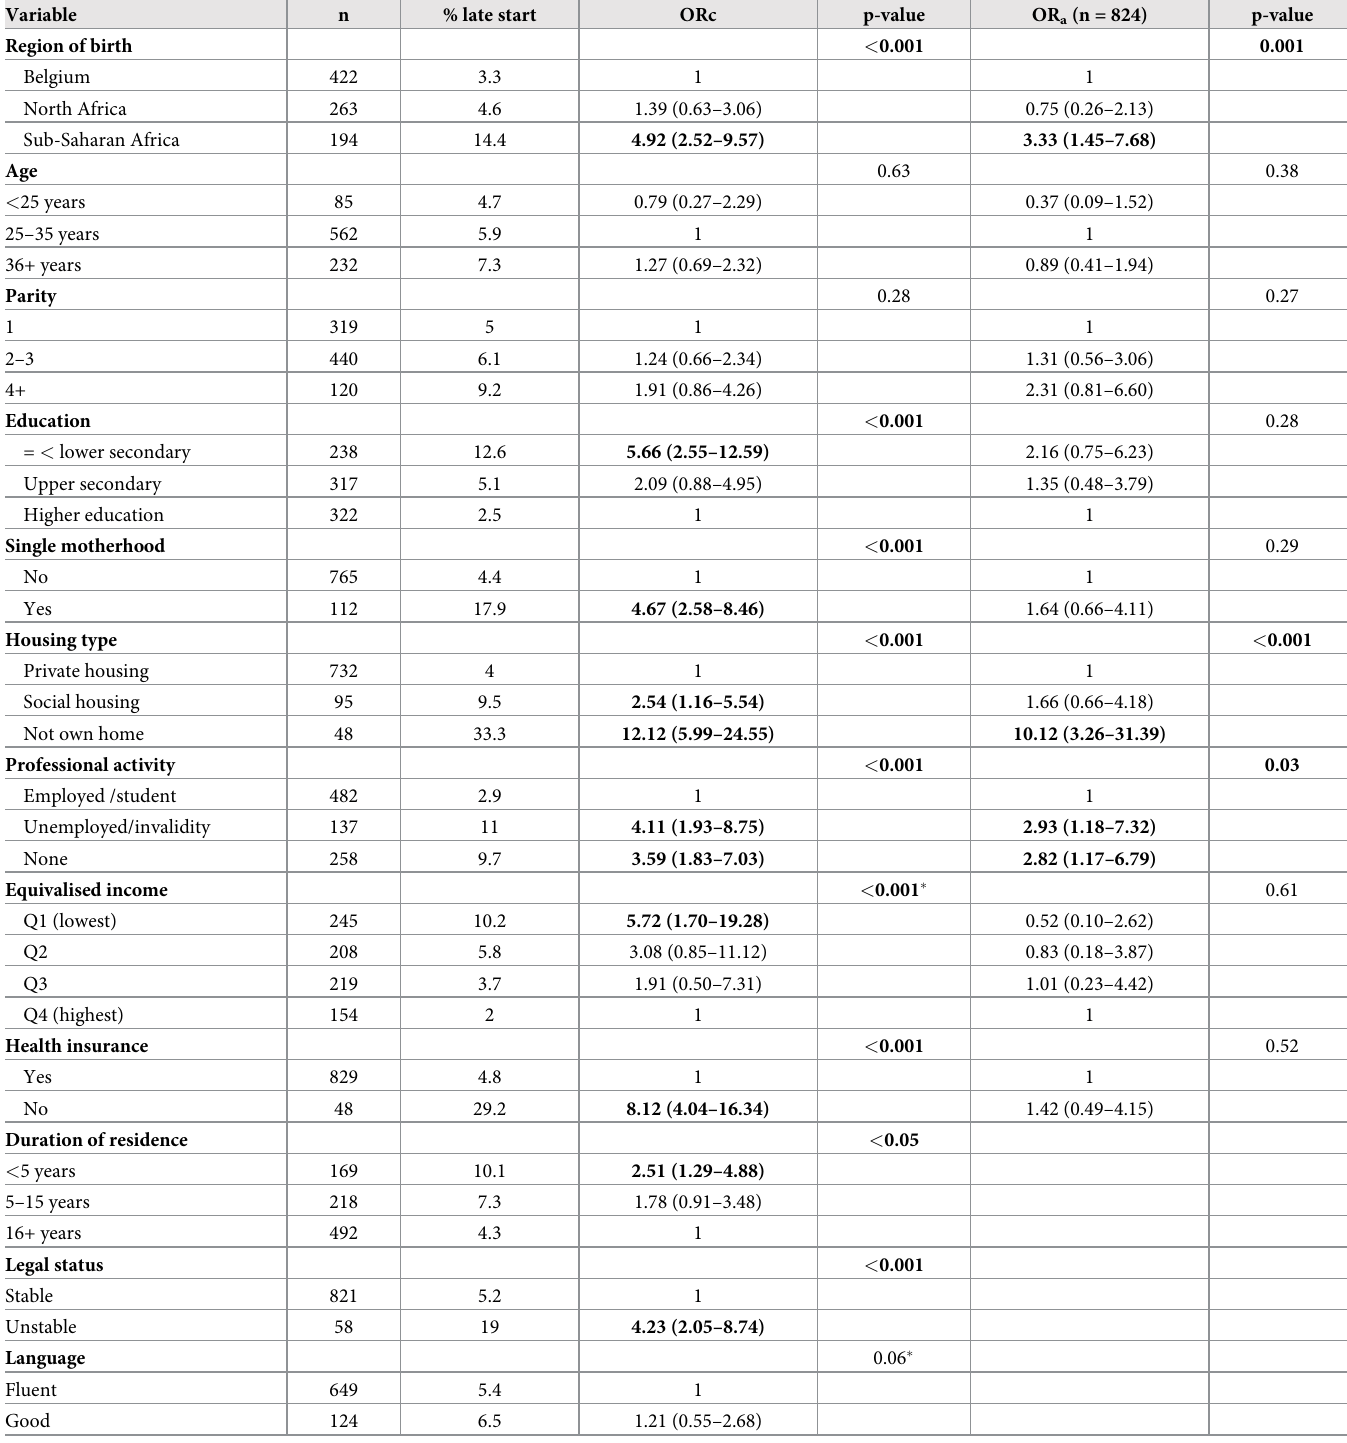
Table 3. Crude and adjusted odds ratios and p-values for predictors of late start of